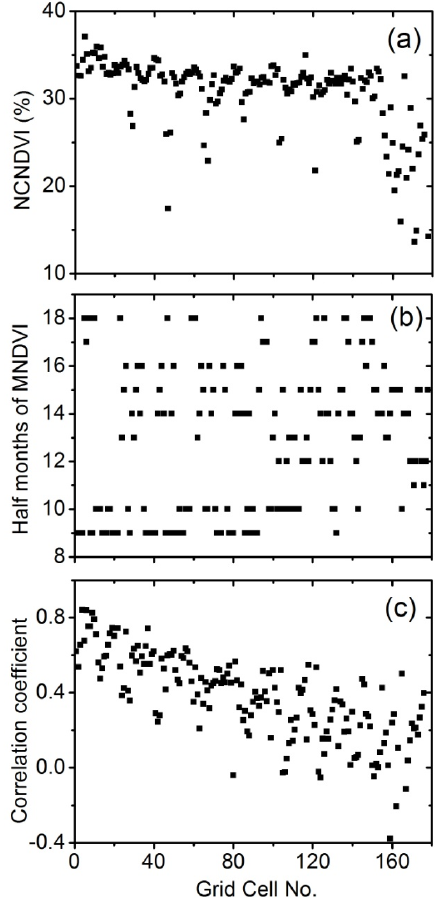
Figure 4. ( a ) The normalized cumulative NDVI (NCNDVI), ( b ) the maximum NDVI (MNDVI); and ( c ) the correlation coefficient between MNDVI and precipitation in the 178 grid cells (note: grid cell number is the grid cell ID as shown in Figure